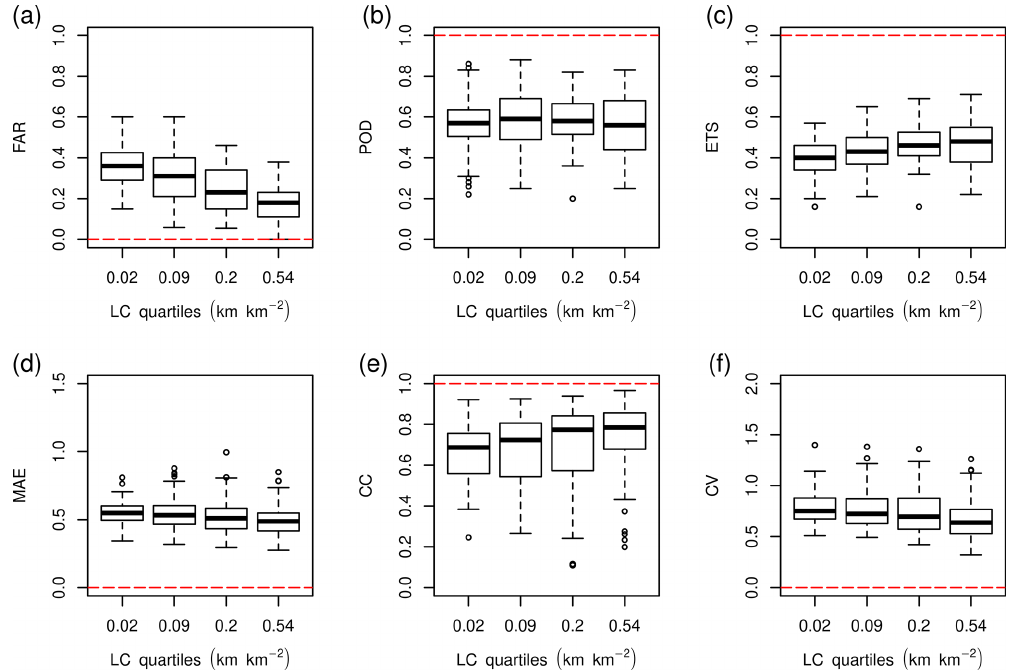
Figure 6. Distributions of four statistical indicators computed for every grid box and grouped in box plots by quartiles of the link coverage LC (labelled by the quartiles’ centres). Dashed red lines are the optimal values for each score. Table 4. Rainfall characteristics and performance indicators for the three 1d case studies. Date Mean R Max R Wet FAR POD ETS ME CV CC (mm) (mm) fraction 19.05 2.60 24.0 0.37 0.10 0.77